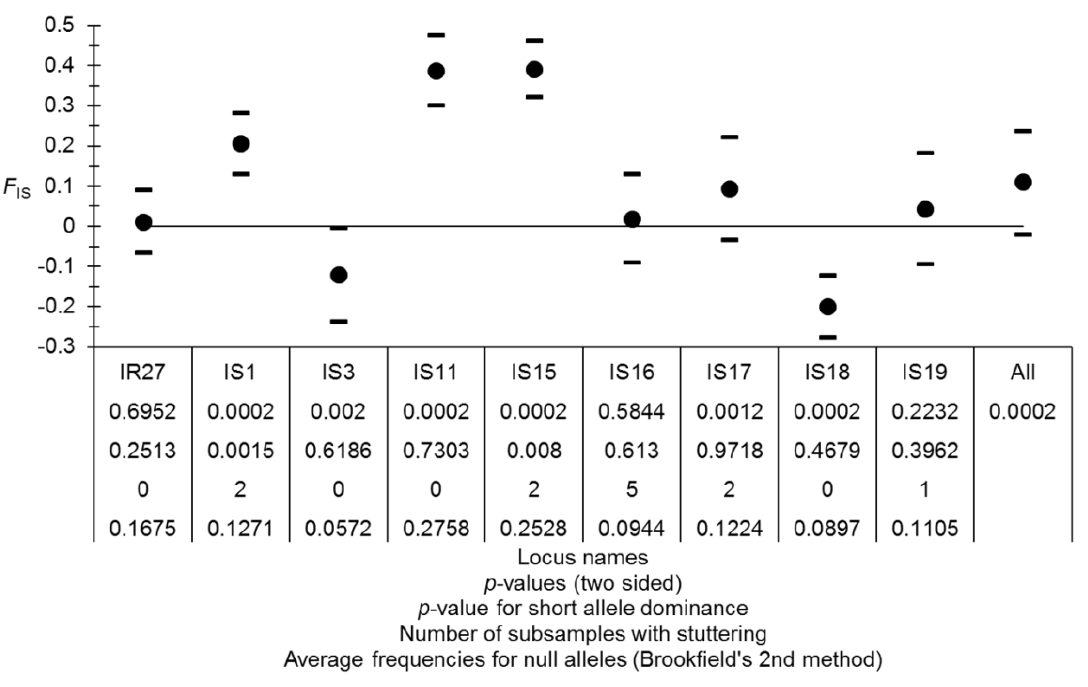
Figure 2. F IS values for each locus and averaged across those (All) of Ixodes scapularis from the eastern U.S.A. with 95% jackknife confidence intervals over subsamples (for each locus) and bootstraps over loci (All). Results of tests for panmixia, short allele dominance, number of subsamples with stuttering for each locus, and null allele frequencies are also